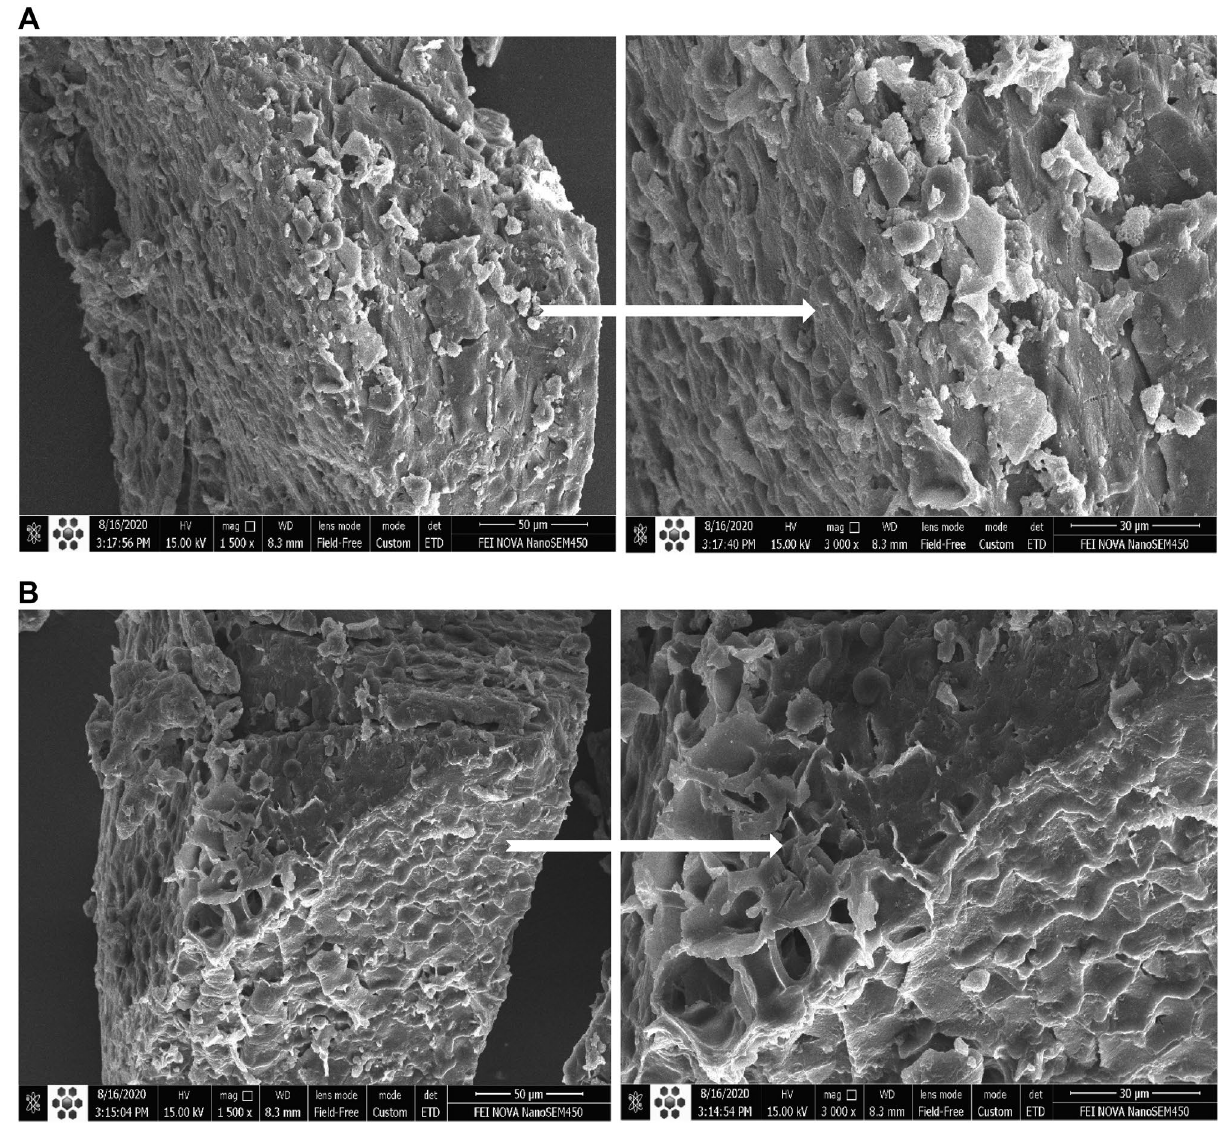
Figure 5. Scanning electron micrographs of unfermented corn ( A ) and corn after SSF and enzyme cocktail treatment ( B ). Left: under a magnification of 1500 × . Right: under a magnification of 3000 ×